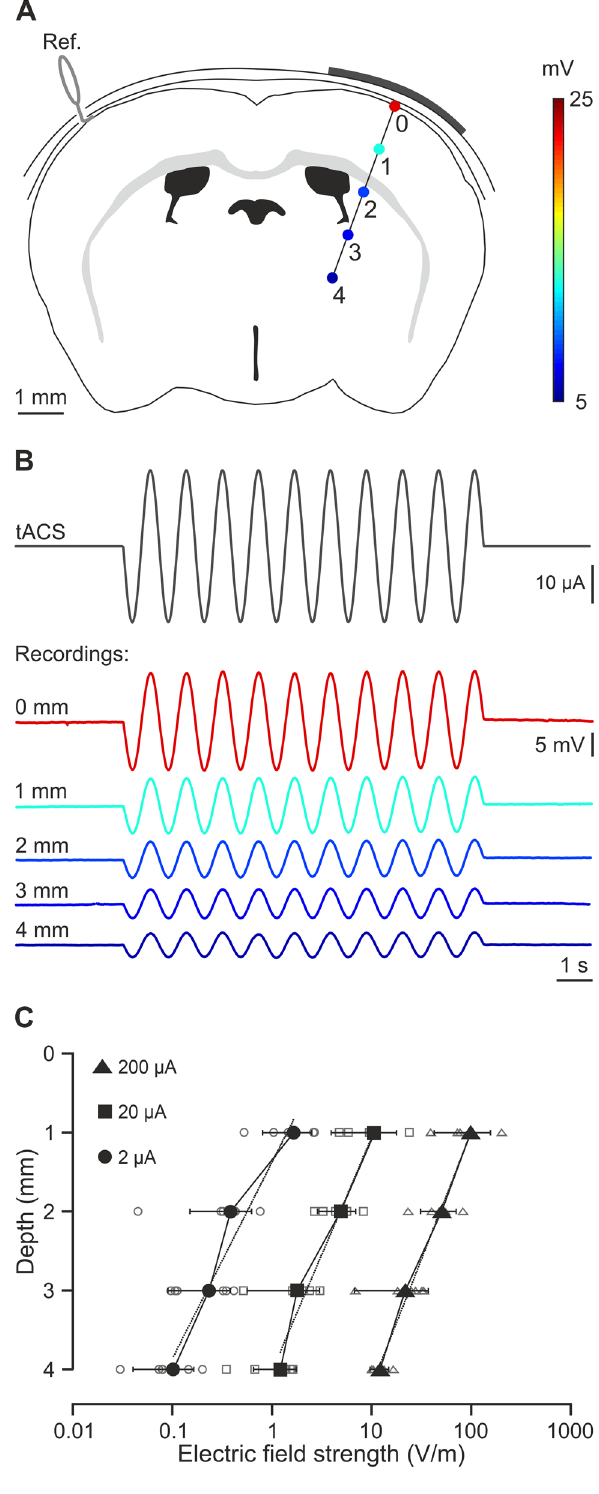
Figure 2. Intracranial electric fields induced by S1-tDCS. ( A ) Schematic representation of electric potentials recorded in S1 at different depths. ( B ) tACS stimulation (top trace) applied over the scalp and grand average (n = 6 mice, unprocessed data) of the actual potentials generated at different depths (from 0 to 4 mm). ( C ) Average (filled symbols) and individual (empty symbols) electric fields recorded at different depths for ± 2 (circles), ± 20 (squares) and ± 200 μA (triangles)